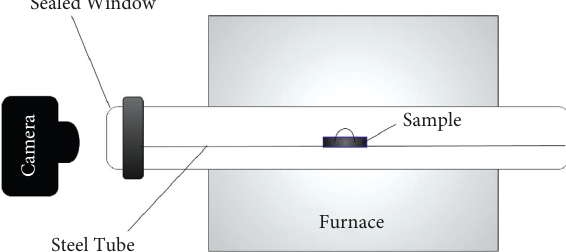
Figure 2: Schematic image showing how the images were obtained when zirconia-veneering ceramic assemblies were in the